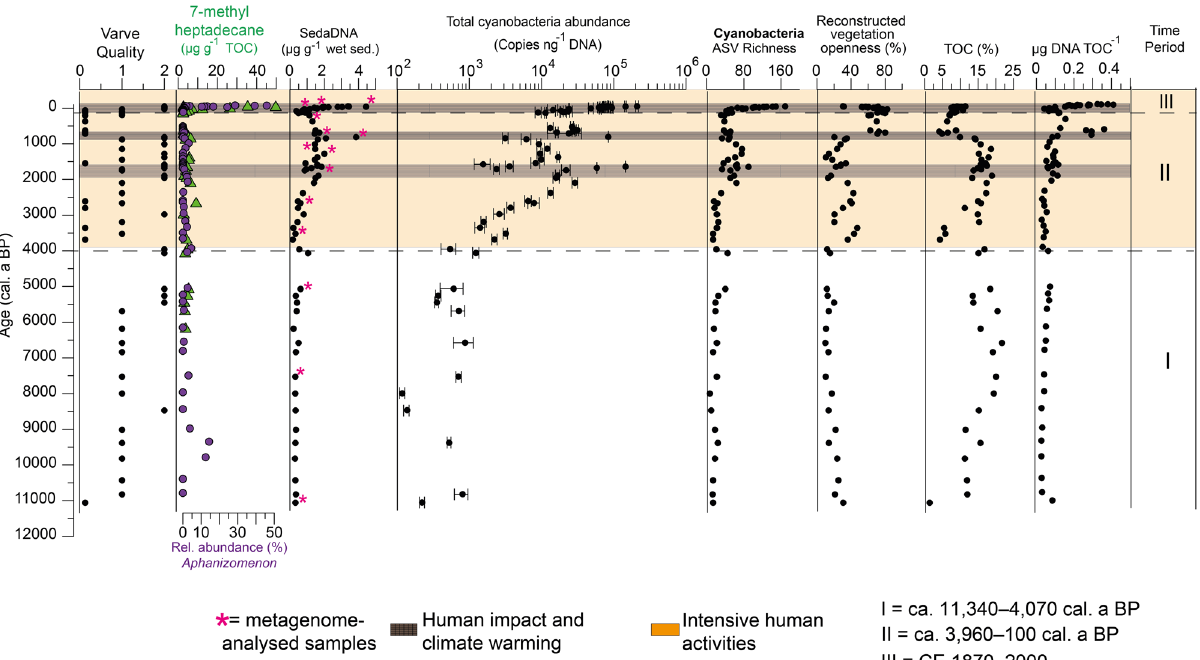
Fig. 2 Sediment chronology with sedimentological parameters, sedaDNA content, information on cyanobacteria abundance and alpha diversity, and selected lake paleoenvironmental records. Sedimentological analysis: Varve quality (where 0 = non-varved, 1 = poorly varved, and 2 = varved). Abundance of ASVs assigned to Aphanizomenon relative to total cyanobacterial ASVs (in %) based on amplicon sequencing shown for the entire Holocene (purple dots) compared to 7-methylheptadecane normalised to total organic carbon lipid biomarker shown up to ca. 6500 cal. a BP (green triangles; µ g g − 1 TOC). Microbiological analysis: SedaDNA concentration was normalised to sediment weight ( µ g DNAg − 1 sed; magenta-coloured stars indicate metagenome-analysed samples) and to total organic carbon content ( µ g DNA TOC − 1 ); total cyanobacteria abundance was determined via quantitative PCR; error bars give the standard deviations for three independent ampli fi cations; cyanobacteria taxonomic richness was retrieved from amplicon sequencing and ASV analysis. Geochemical analyses: TOC contents. Pollen-based reconstructed vegetation openness data 27 . Dashed black lines demarcate three signi fi cantly different temporal clusters identi fi ed by non-metric multidimensional scaling (I) ca. 11,340 – 4070 cal. a BP, (II) ca. 3960 – 100 cal. a BP, and (III) ca. CE 1870 – 2000 (see Fig. 4). Orange-coloured sections highlight a period with phases of intensive human activities around the study site, while dark-brown grids highlight peaks in cyanobacteria abundance coinciding with warming